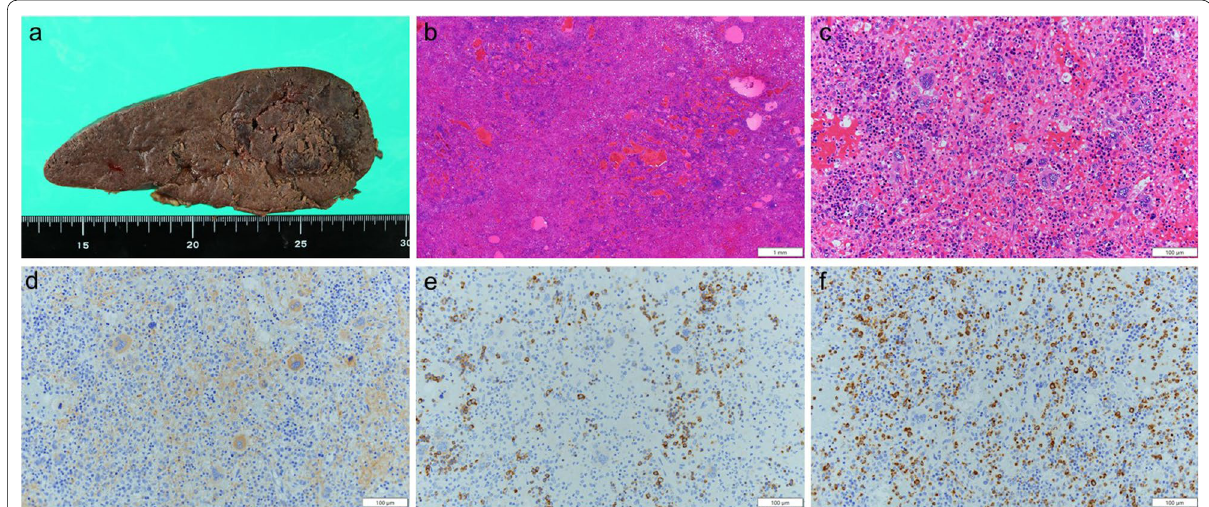
Fig. 3 Histologic examination and immunohistochemistry of the tumor. Histologic examination revealed a 125 tumor ( a arrowheads). Outgrowths of granular cells and erythroid cells were observed in the tumor [hematoxylin and eosin stain, Immunohistochemistry was positive for CD 71 ( d ), CD 41 ( e ), myeloperoxidase ( f ), and hematopoietic cells, including erythroblasts, granulocytes, and megakaryocytes ( 20) ×